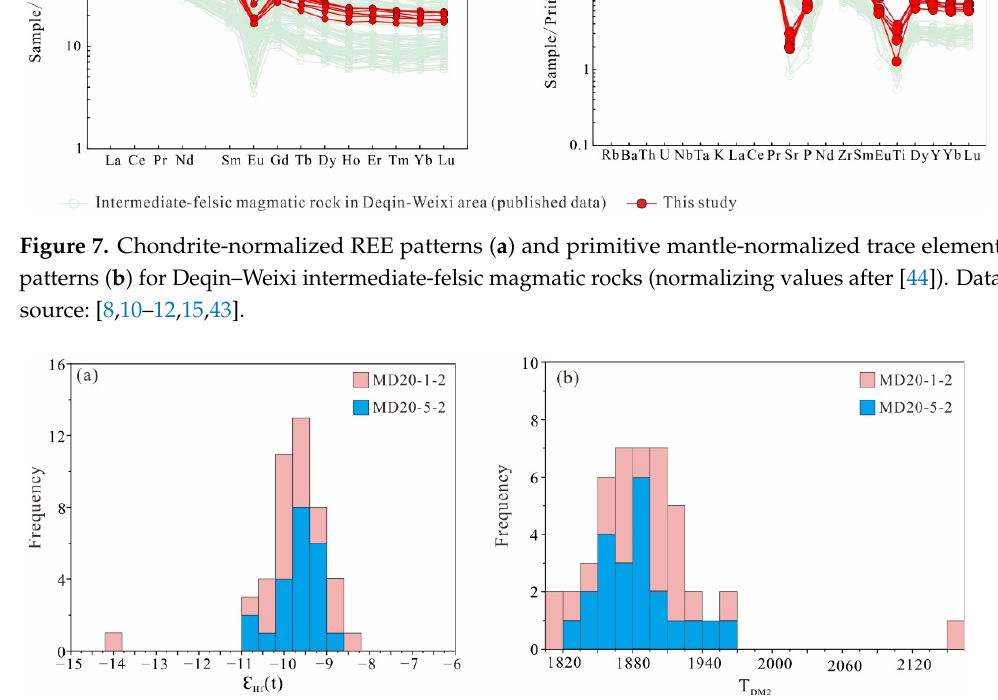
Figure 8. Histograms of ε Hf (t) ( a ) and two-stage Hf model age (T DM2 ) ( b ) of the Madeng dacite .